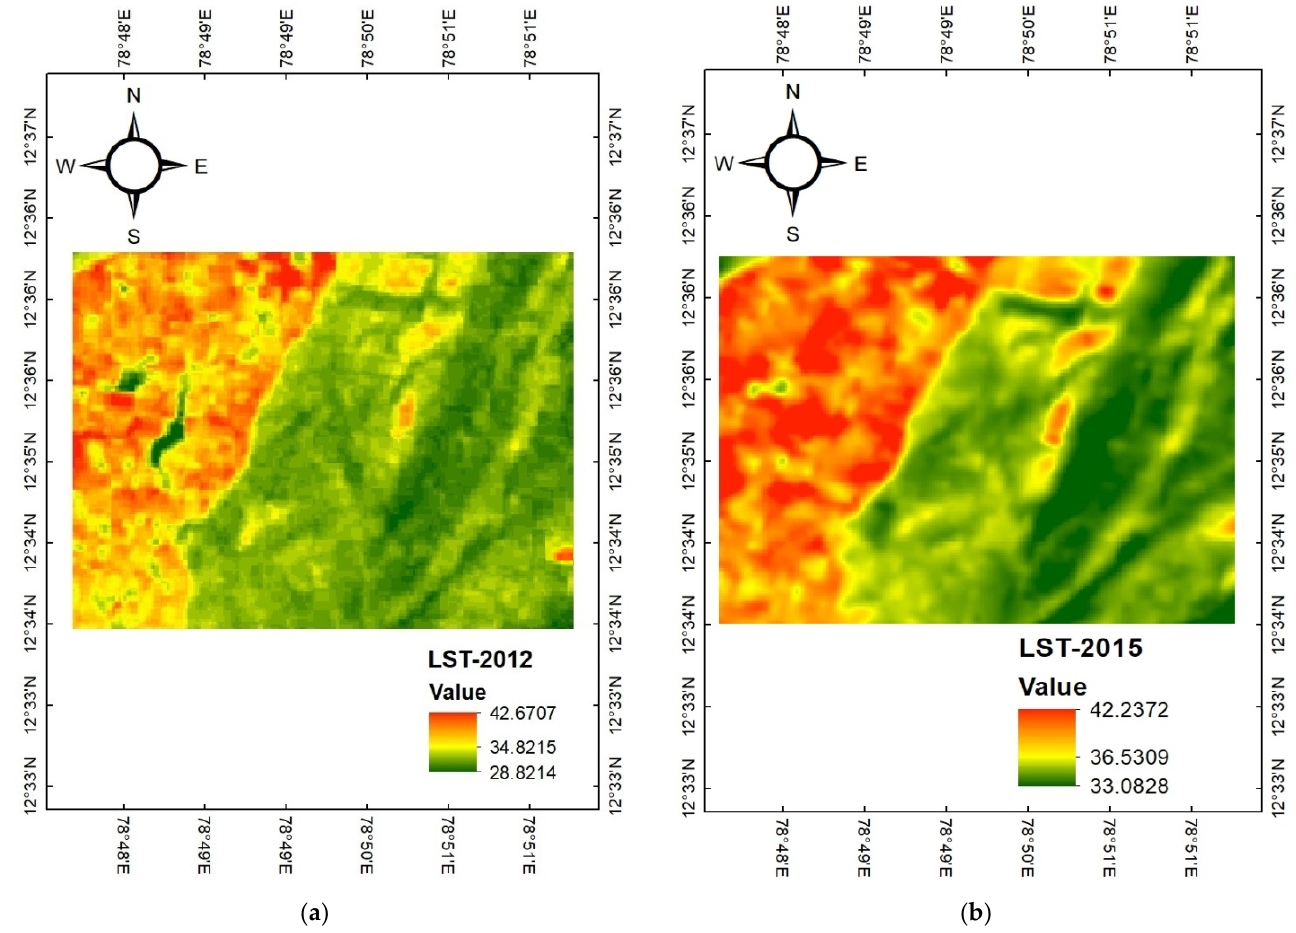
Figure 10. LST map for the area of Javadi Hills for the years ( a ) 2012 and ( b ) 2015.